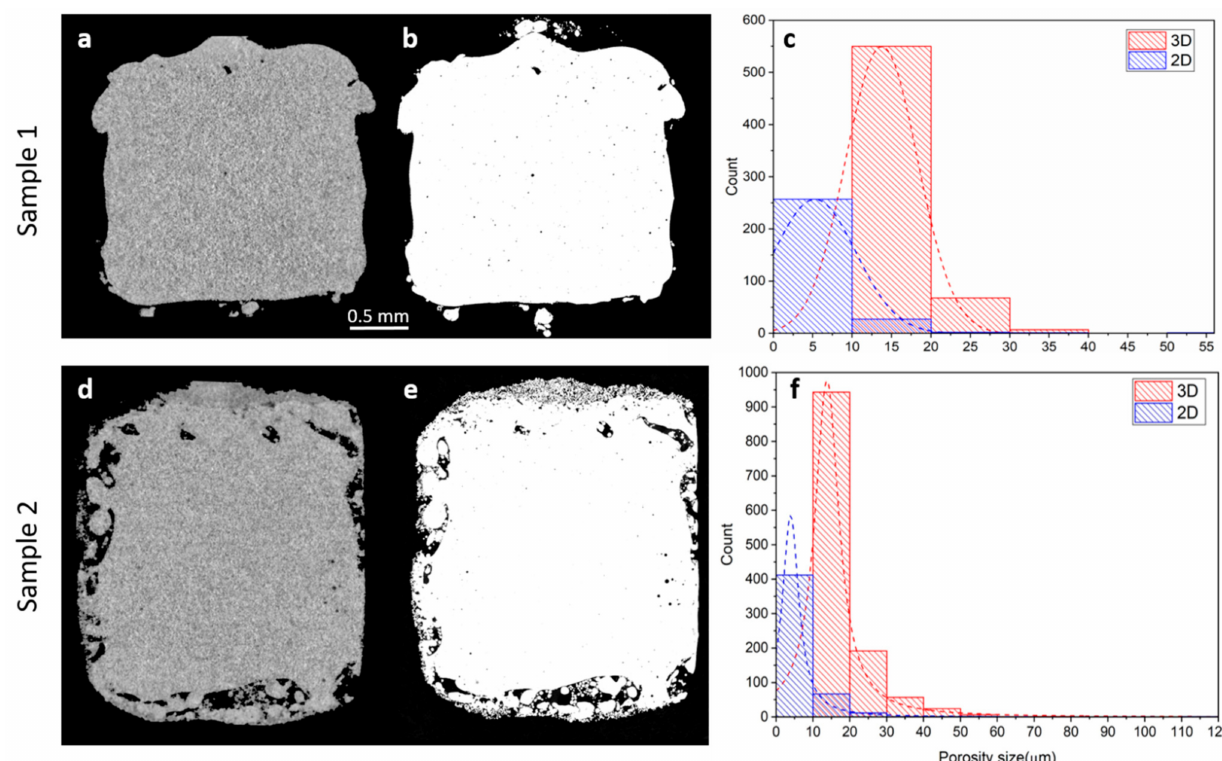
Figure 2. Comparison of the neutron microtomography ( a , d ) sections and their equivalent optical microscopy ( b , e ) sections. Graphs ( c , f ) show pore size distributions extracted from the full volume of the 3D neutron microtomography datasets and from a single slice of optical microscopy ( b , e ) sections,